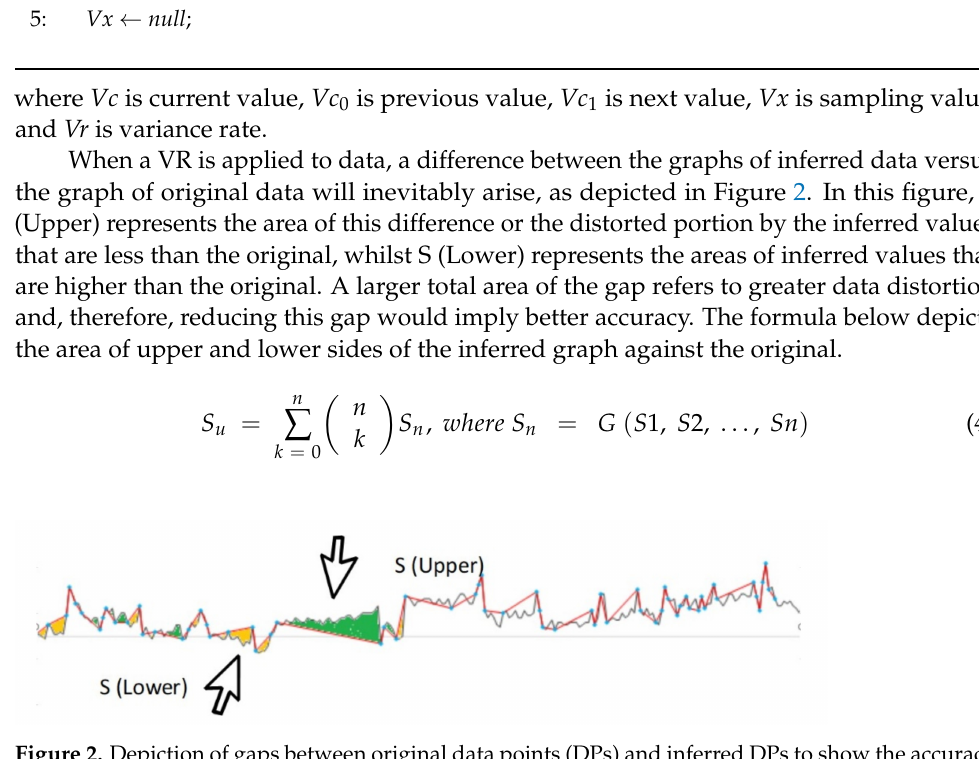
Figure 2. Depiction of gaps between original data points (DPs) and inferred DPs to show the accuracy of the calculation